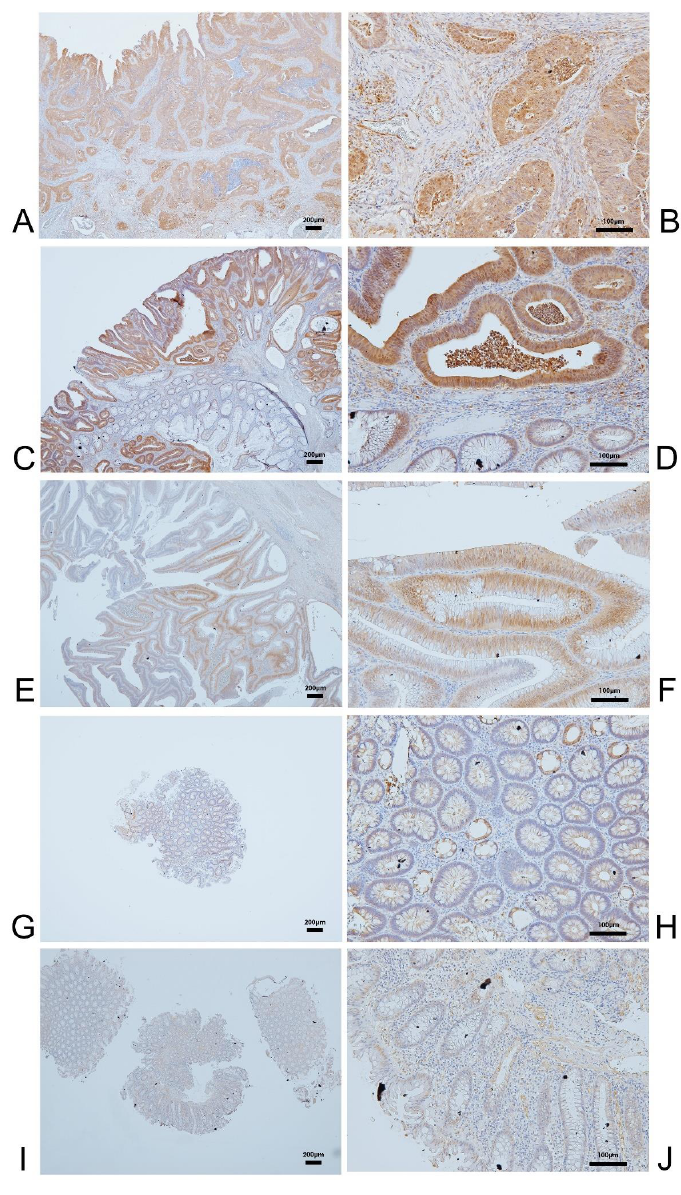
Figure 3. IHC of eNAMPT in colonic polyps. Representative cases of adenocarcinoma ( A , B ), adenoma with high-grade dysplasia ( C , D ), adenoma with villous components ( E , F ), simple adenoma ( G , H ), and hyperplastic polyps ( I , J ) are shown. ( A , C , E , G , I ) 40 × ; ( B , D , F , H , J ) 200 × . The eNAMPT-positive cells are stained